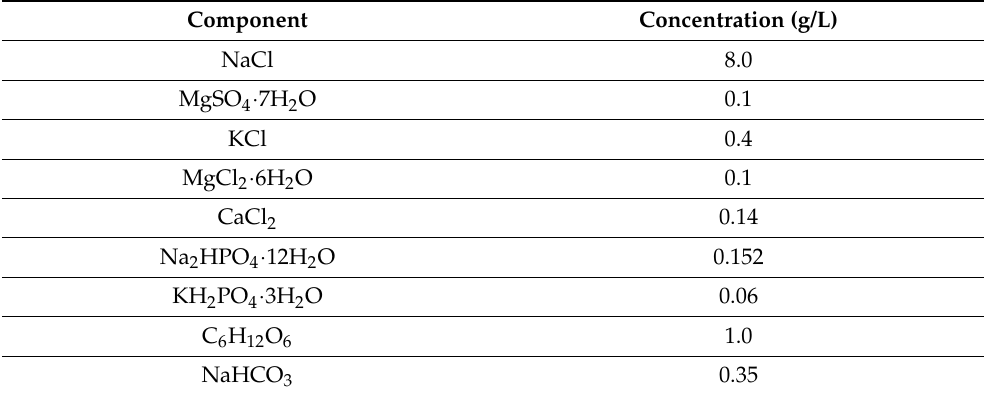
Table 1. Formula of